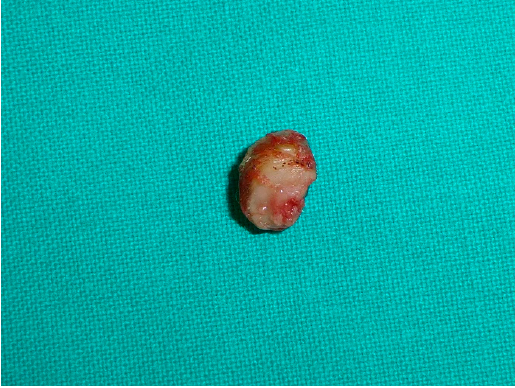
Figure 4. Note subungual osteochondroma mass.